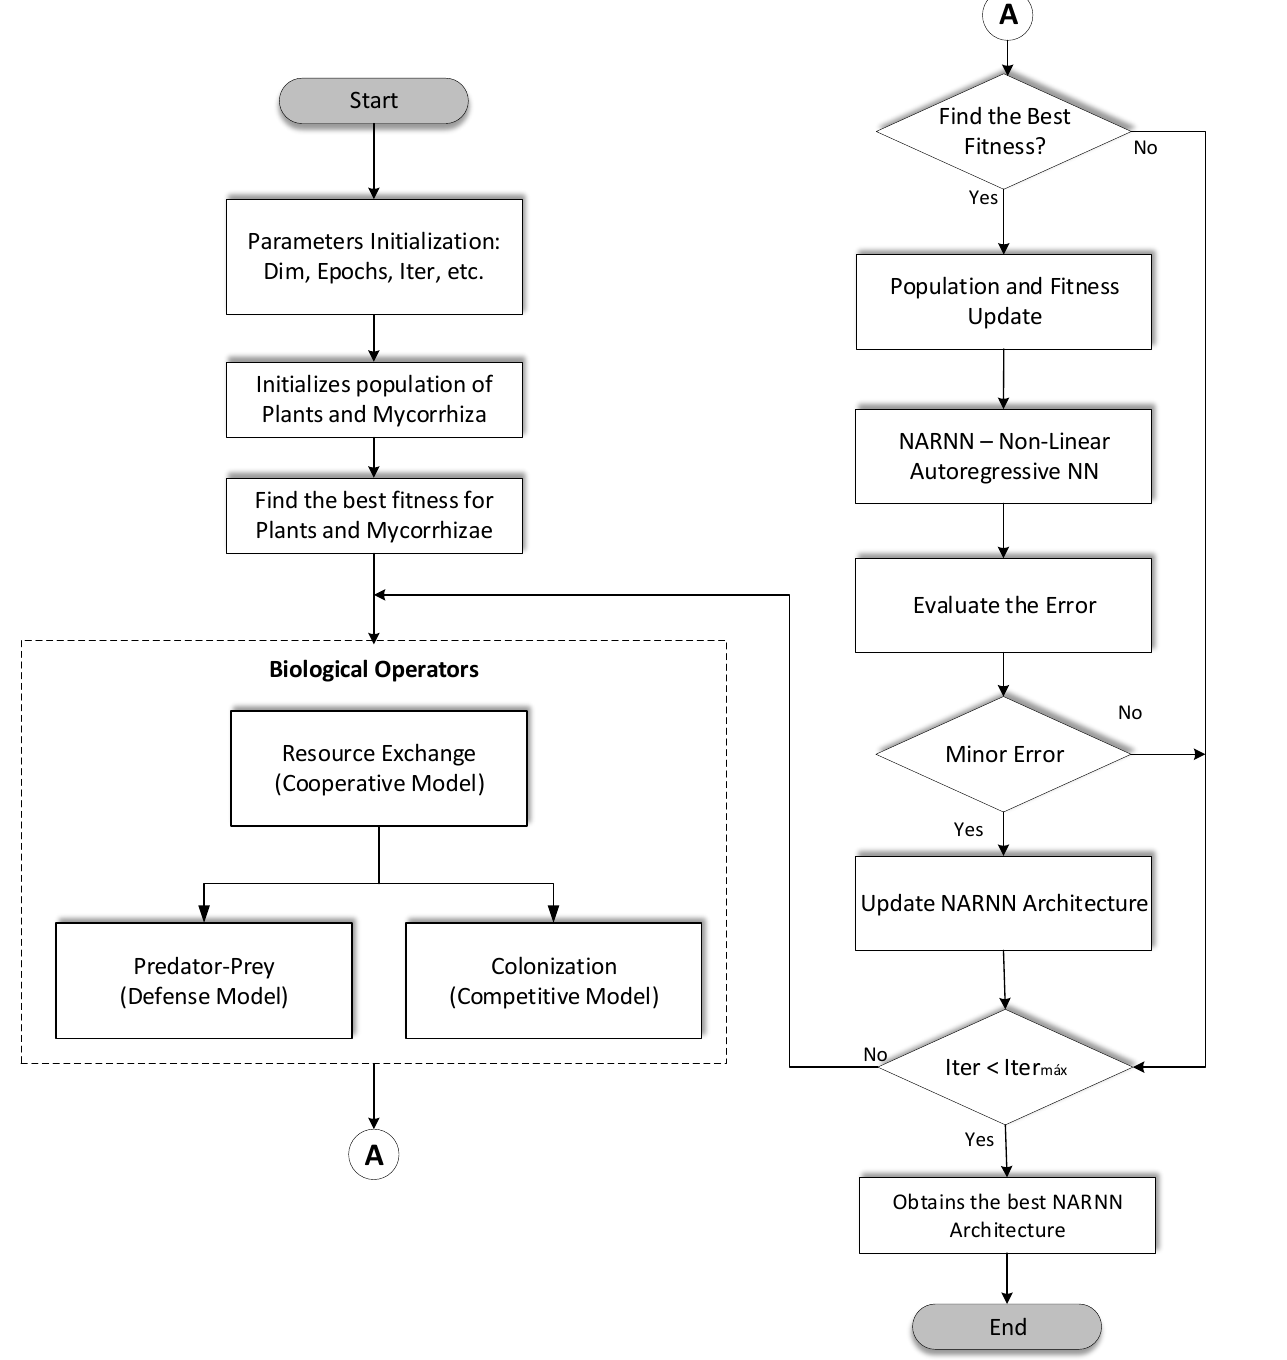
Figure 7. DMOA-NARNN Flowchart. Discrete models driven by difference equations are more suitable than continuous models when reproductive generations last only one breeding season (no overlapping generations)